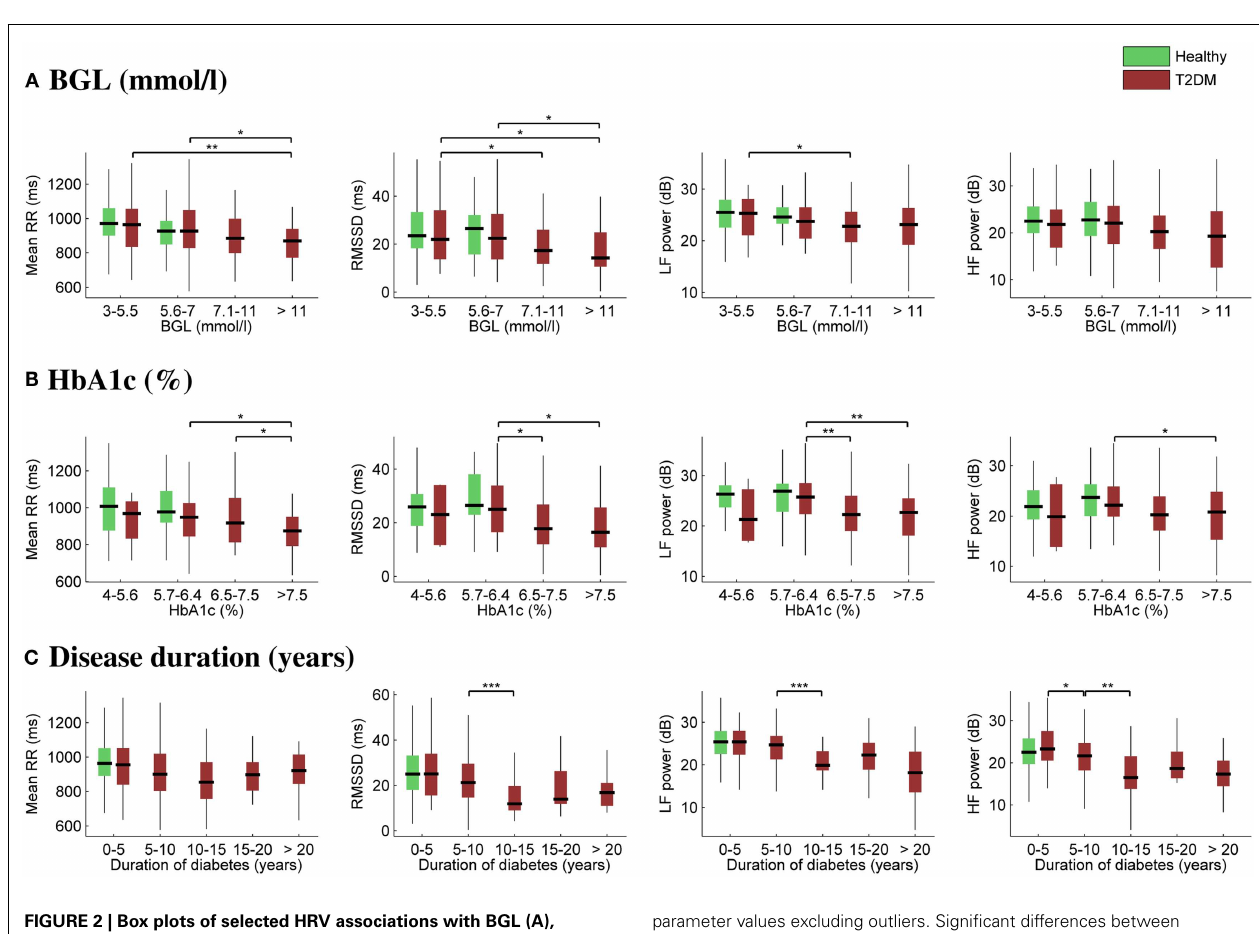
FIGURE 2 | Box plots of selected HRV associations with BGL (A), HbA1c (B), and duration of diabetes (C) . On each box, the central mark is the median, the edges of the box are the 25th and 75th percentiles, and the whiskers extend to the most extreme